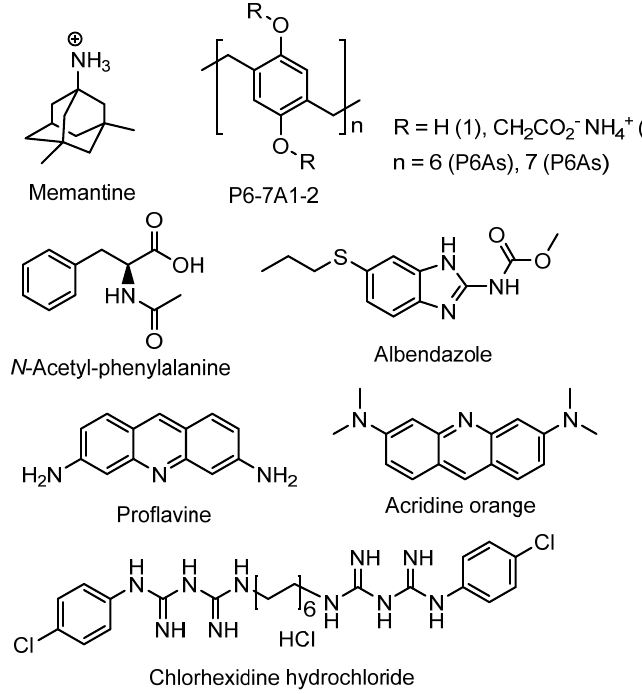
Figure 1. The formation of “ WP5 –antibiotic” inclusion complexes. Reproduced with the permission of reference [67]. Copyright © Royal Society of Chemistry 2018.